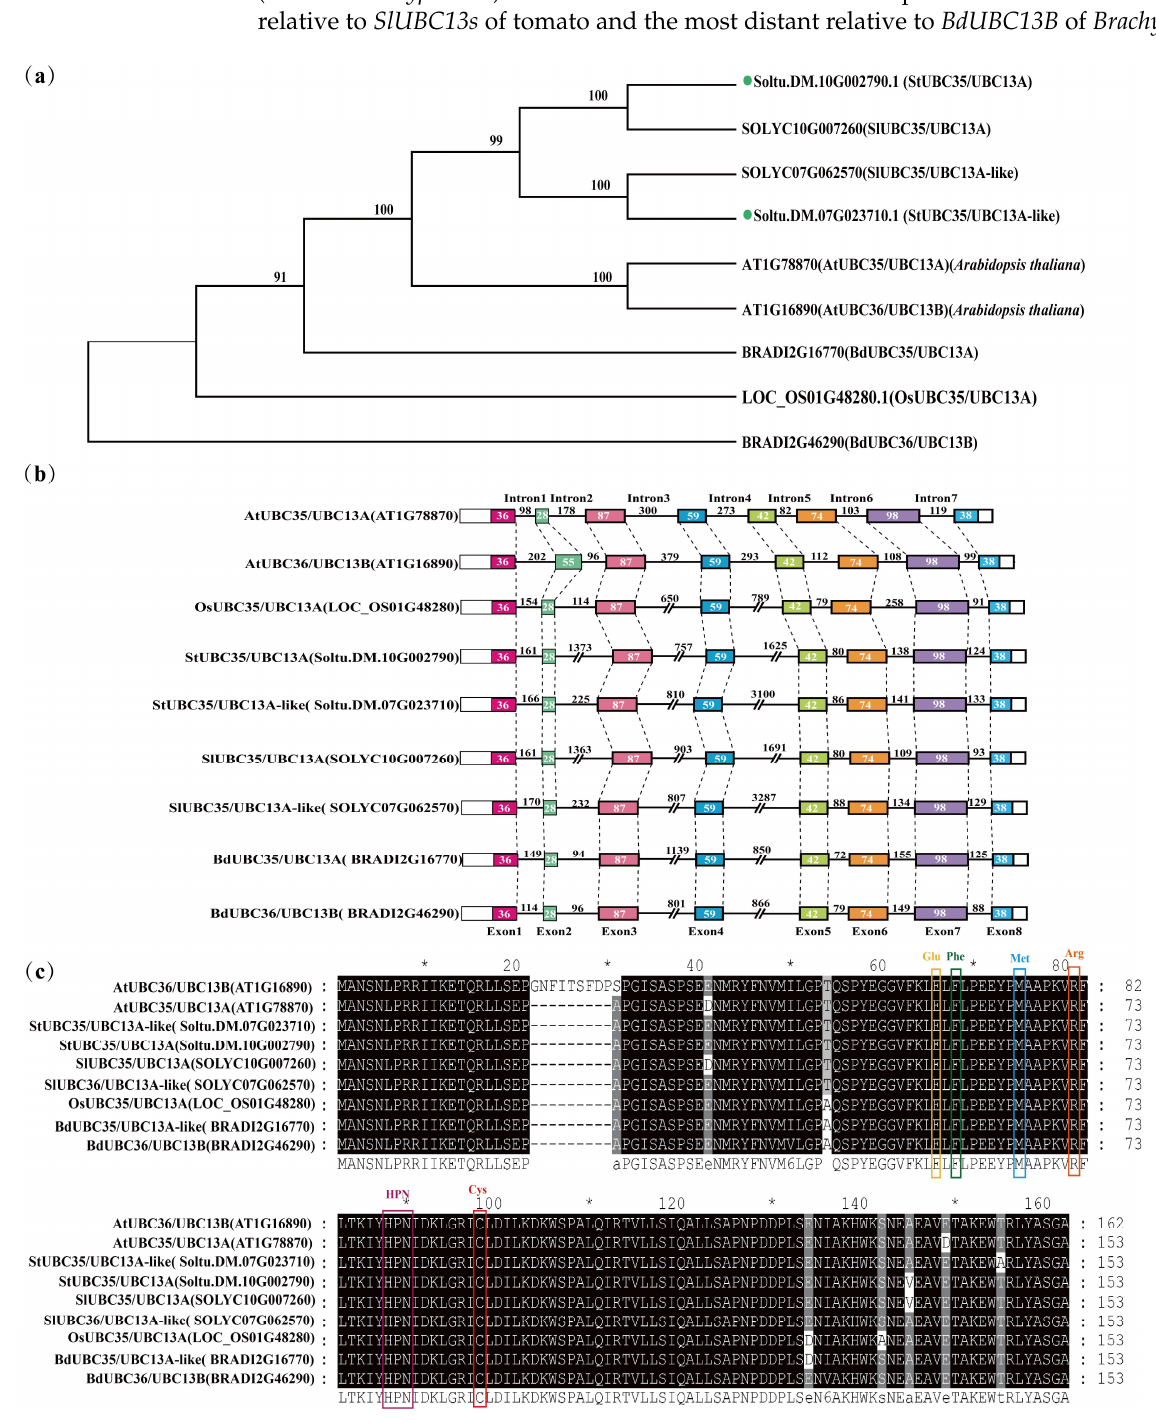
Figure 3. The characterization of StUBC13 . ( a ) Phylogenetic relationships of UBC13 from Oryza sativa , Arabidopsis thaliana , Brachypodium distachyon , Solanum lycopersicum , and Solanum tuberosum . ( b ) Gene structure analysis of UBC13. ( c ) Protein sequence alignment of UBC13. * indicates that this residue is conserved.